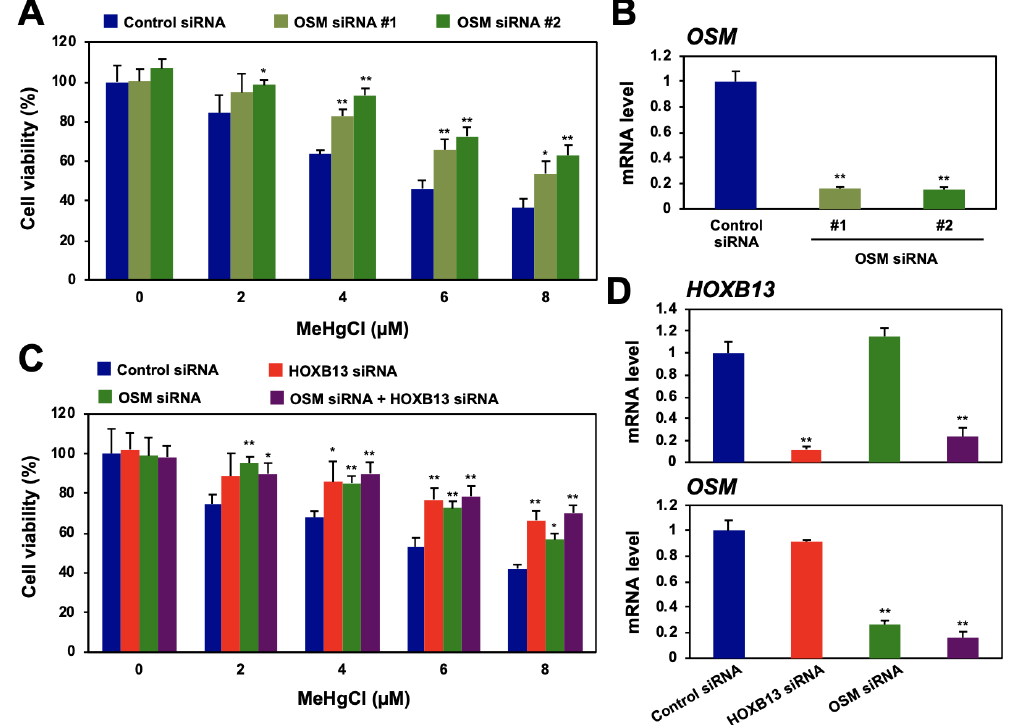
Figure 2. Effects of oncostatin M (OSM) and HOXB13 knockdown on cytotoxicity caused by methylmercury. ( A ) HEK293 cells were transfected with control siRNA or two different sequences of OSM siRNA (#1 or #2) for 48 h and exposed to indicated concentrations of methylmercuric chloride (MeHgCl) for 24 h. Cell viability was measured by alamarBlue assay. ( B ) qPCR for OSM mRNA was performed. Representative data indicate relative values, with control as 1, normalized to each GAPDH mRNA level. ( C ) Cells were transfected with control siRNA, OSM siRNA (#2), and/or HOXB13 siRNA for 48 h and exposed to indicated concentrations of MeHgCl for 24 h. Cell viability was measured by alamarBlue assay. No significant difference was found between HOXB13 siRNA and HOXB13 siRNA + OSM siRNA. ( D ) Control cells (without methylmercury exposure) were harvested, and qPCR for OSM mRNA (upper panel) or HOXB13 mRNA (lower panel) was performed. Representative data indicate the relative values, with control as 1, normalized to each GAPDH mRNA level. All values are mean ± S.D. of three individual experiments. * p < 0.05 vs. control siRNA, ** p < 0.01 vs. control siRNA.